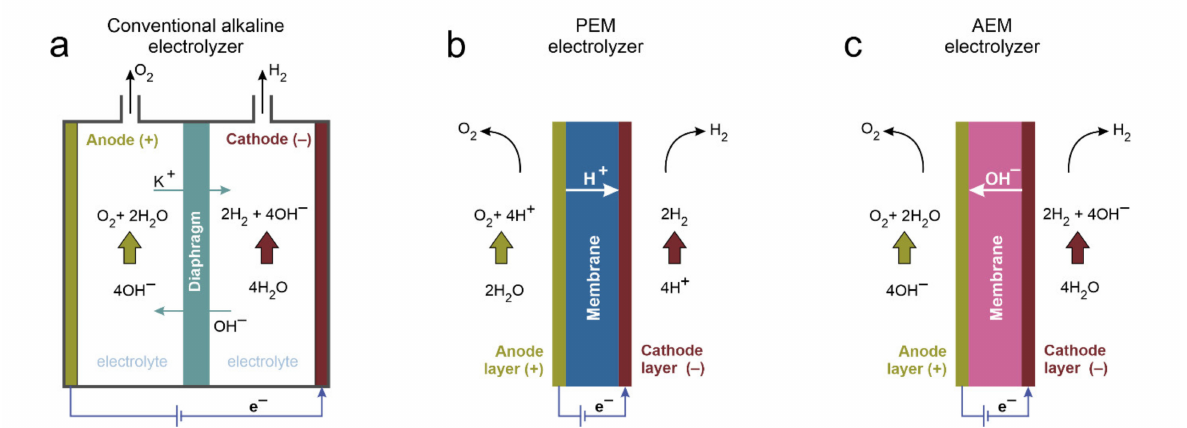
Figure 3. Schematic diagrams of electrolyzers for low temperature water splitting. Commercially available technologies: ( a ) liquid KOH and ( b ) proton exchange membrane (PEM) electrolyzers. Development stage technology: ( c ) anion exchange membrane (AEM)